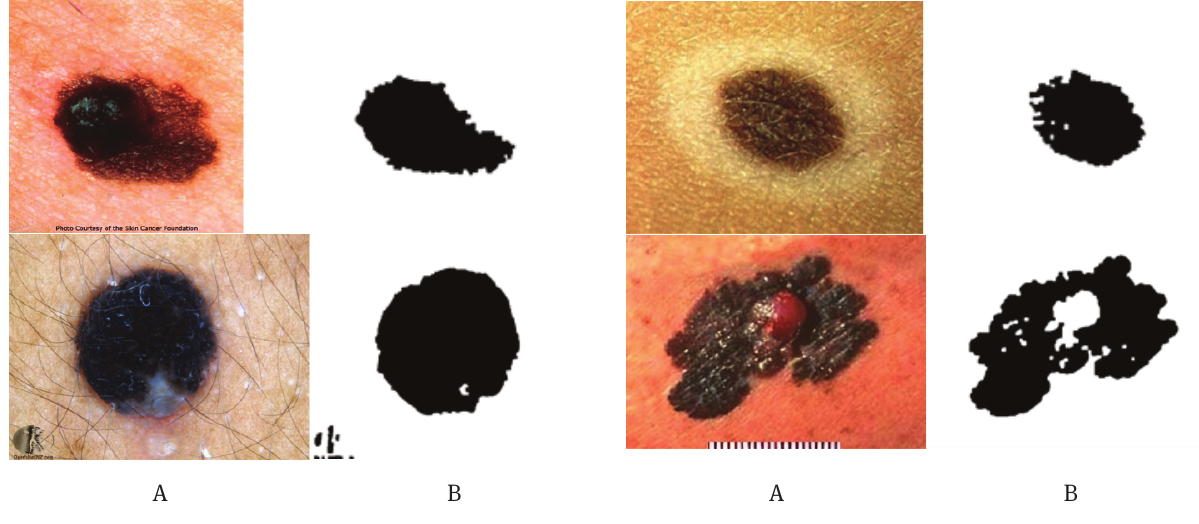
Figure 6: Some of the results of the algorithm: (A) original image and (B) segmented